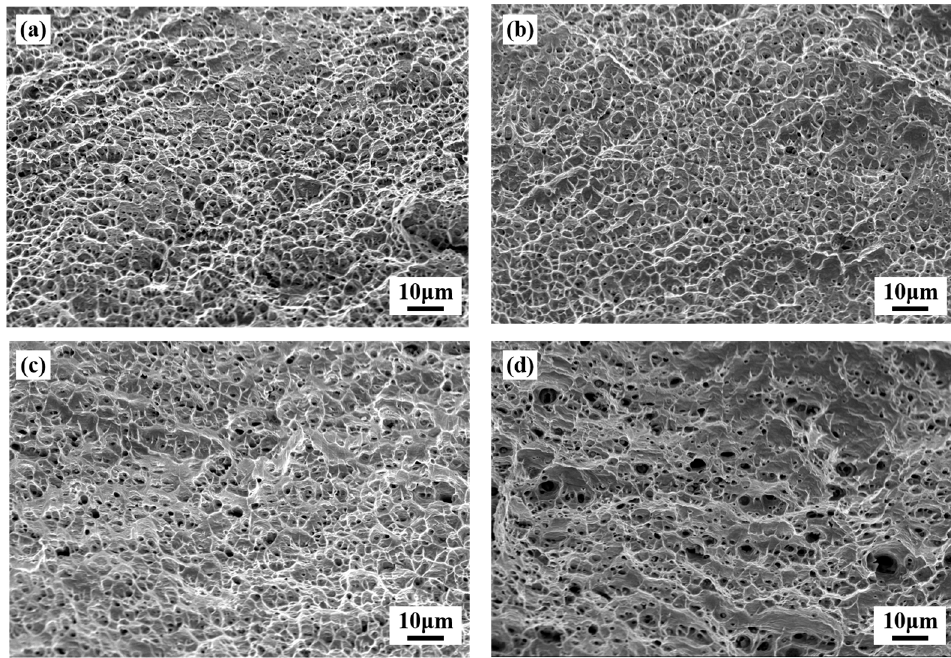
Figure 9. Room temperature tensile SEM fractogram of the deposited state of Inconel 690: ( a ) Inconel 690; ( b ) 1.5 wt.% Mo; ( c ) 2.5 wt.% Mo; ( d ) 3.5 wt.% Mo.